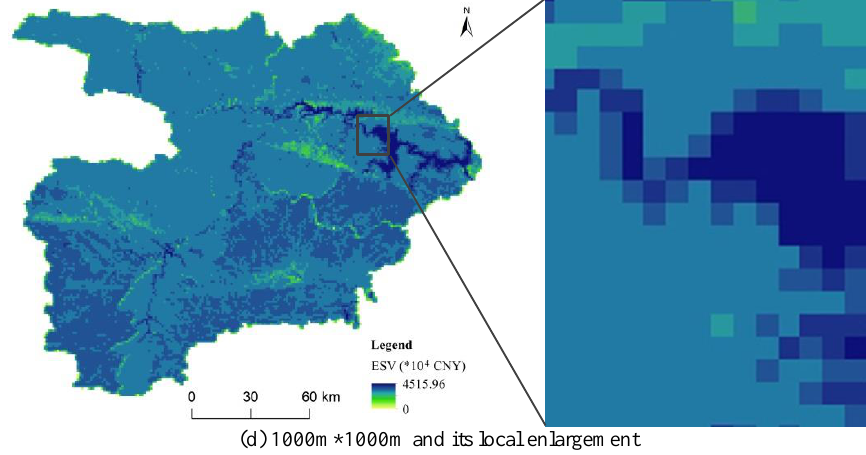
Figure 5. Comparisons of multi scale spatial displays